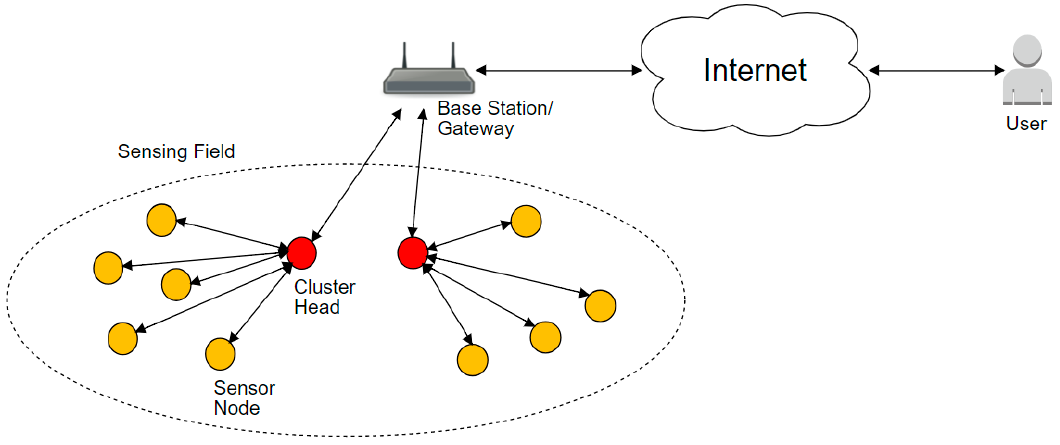
Figure 1. The Network Model. Figure 1. The network